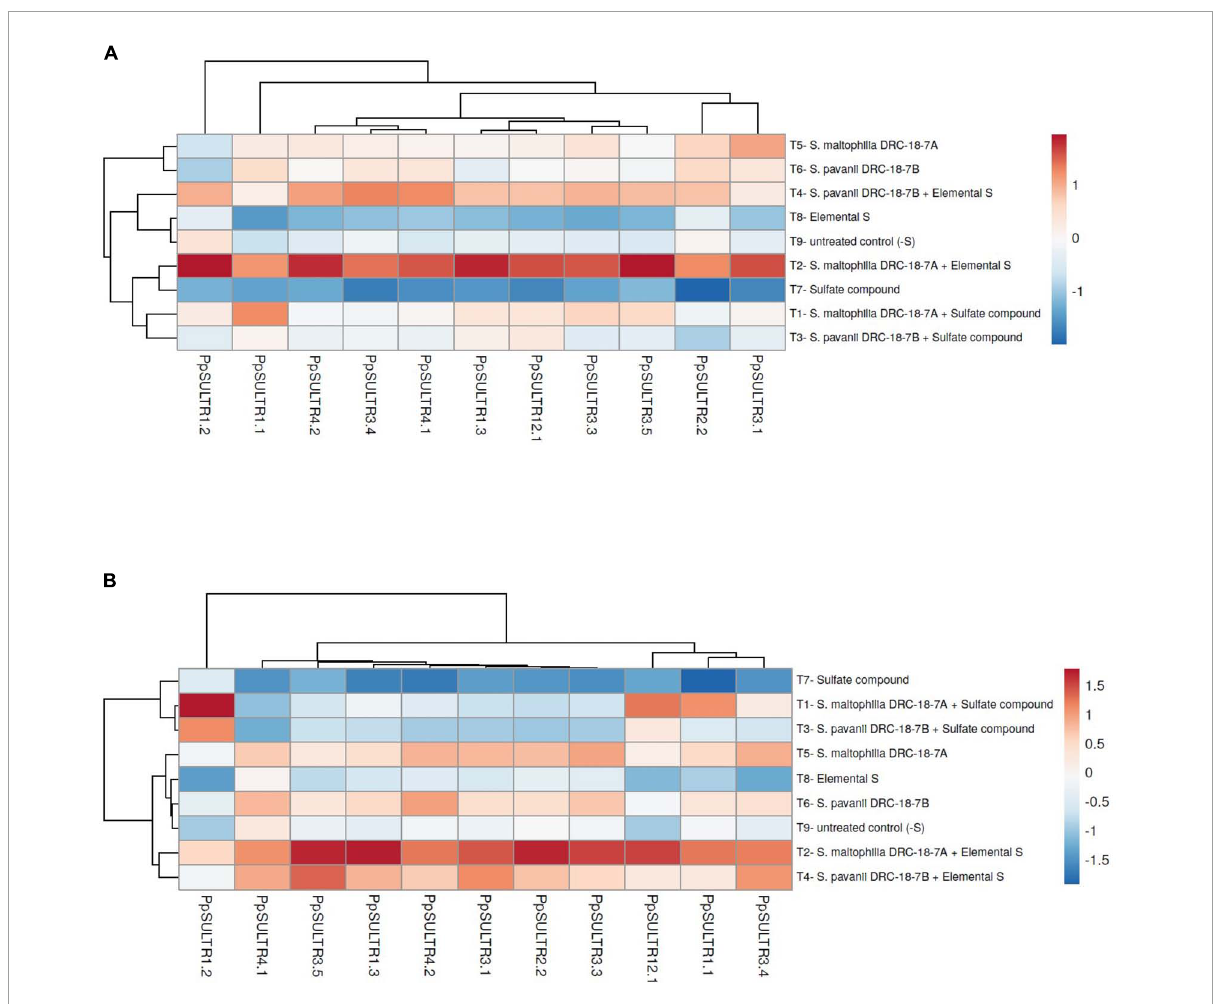
FIGURE5 Heatmap showing the effects of microbial inoculation on expression of SULTR genes in pigeonpea (A) root and (B) shoot at 30 days of sowing T 1 - Stenotrophomonas maltophilia DRC-18-7A + Sulfate compound, T 2 - S. maltophilia DRC-18-7A + Elemental S, T 3 - S. pavanii DRC-18-7B + Sulfate compound, T 4 - S. pavanii DRC-18-7B + Elemental S, T 5 - S. maltophilia DRC-18-7A, T 6 - S. pavanii DRC-18-7B, T 7 -Sulfate compound, T 8 -Elemental S, and T 9 -untreated control